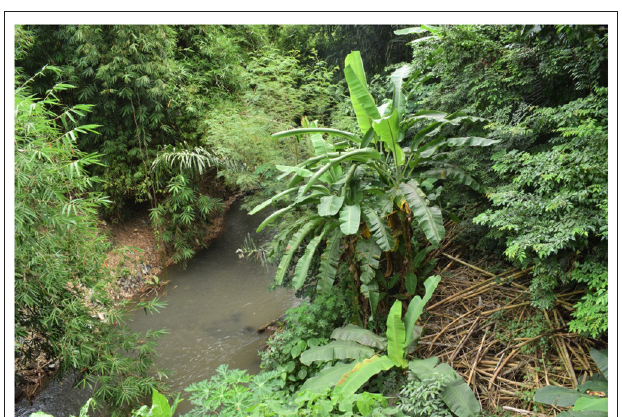
FIGURE 6 | An example of an unsafe riverbank in the Tukad Badung River transition zone area. It is full of detritus, raising the possibility of exposure to reptiles, particularly snakes. Detritus covers the land structure underneath, increasing the risk of accident if the underlying ground is not solid enough for debris collection. There is also no human access to the area (Photo by P.